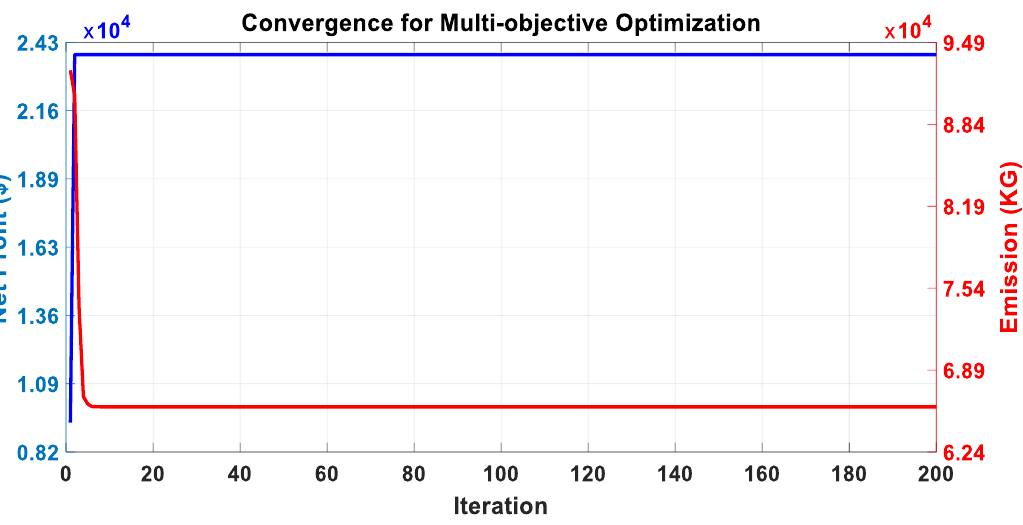
Figure 14. Convergence characteristics of the ABC algorithm for Case III.